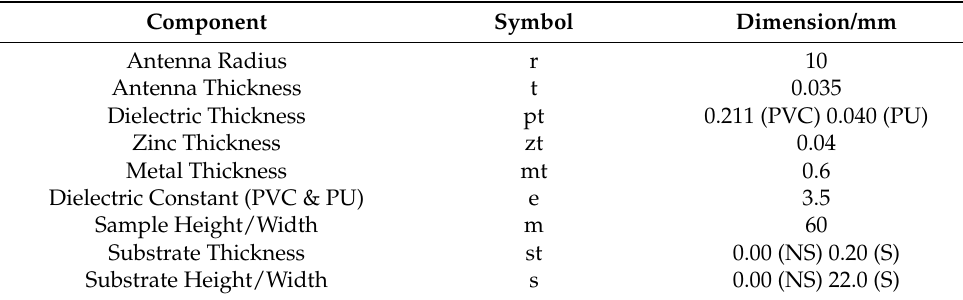
Figure 5. Tag systems showing key dimensions which are defined in Table 1. Table 1. Simulation parameters.